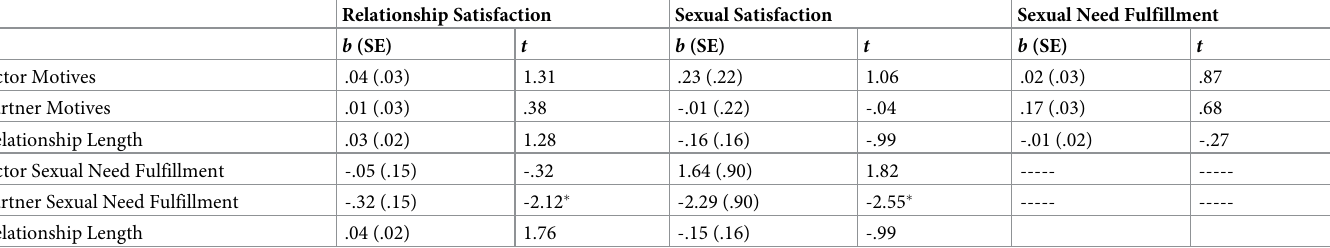
Table 4. Associations between actor and partner sexual motives and sexual need fulfillment with the second partner, and relationship satisfaction and sexual satis- faction with the first